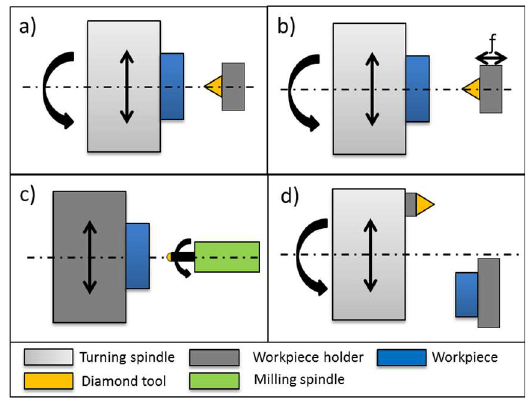
Figure 2. Ultra-precision machining (UPM) methods. ( a ) Diamond turning; ( b ) Slow-tool-servo/fast-tool-servo ( c ) Diamond milling; ( d ) Fly cutting.